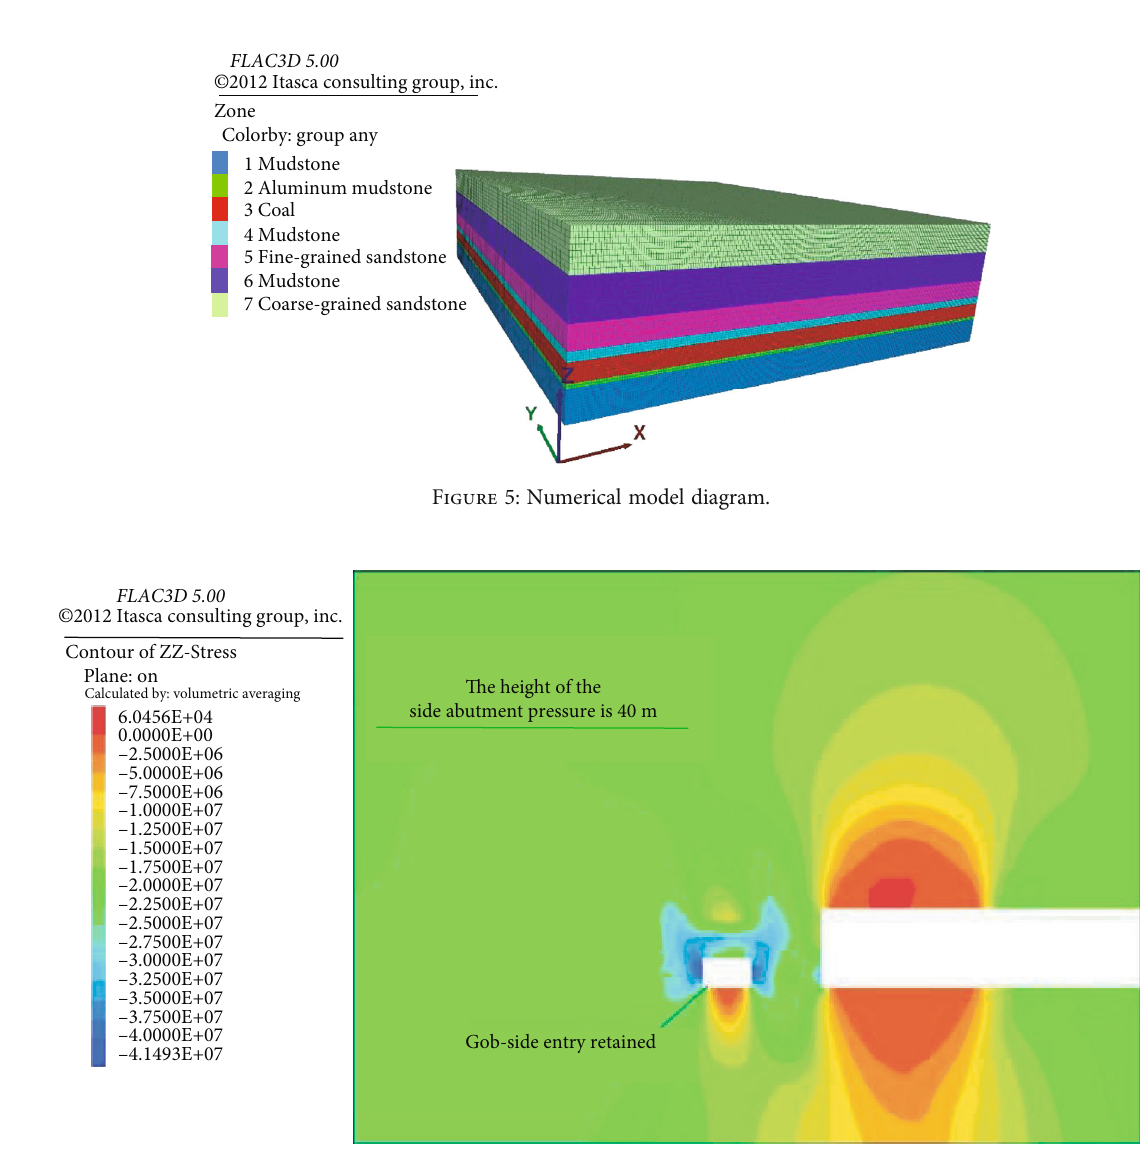
Figure 6: Nephogram of side abutment pressure distribution in the working face.